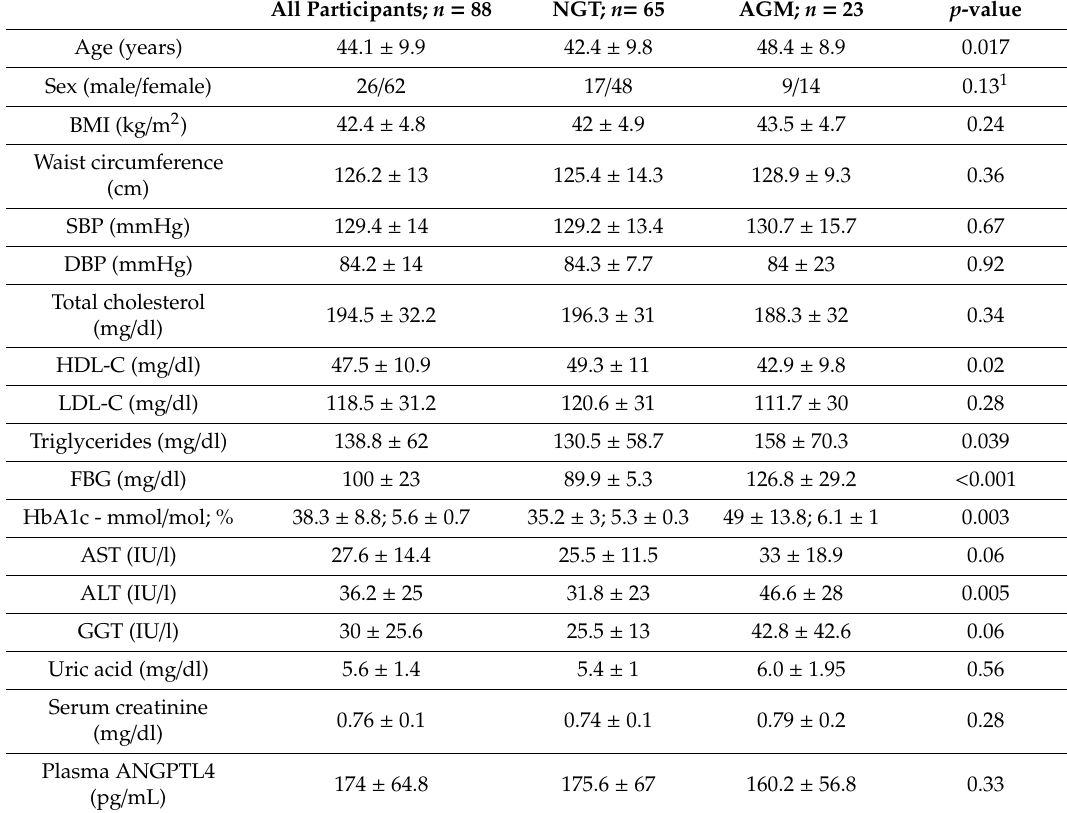
Table 1. Characteristics of the entire study population and in relation to glucose tolerance.